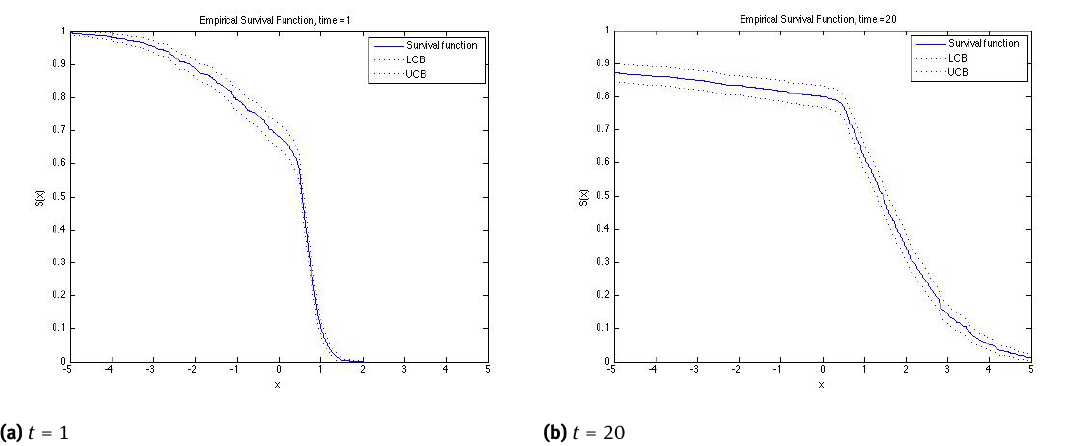
Figure 8: Empirical survival function of X t − Y t in the local correlation model at time t with parameters ν = 0, η = 0.5 , ρ min = −0.9 and ρ max = 0.9 with interval confidence bounds at 99% and estimated with 1000 simulations and a step time of